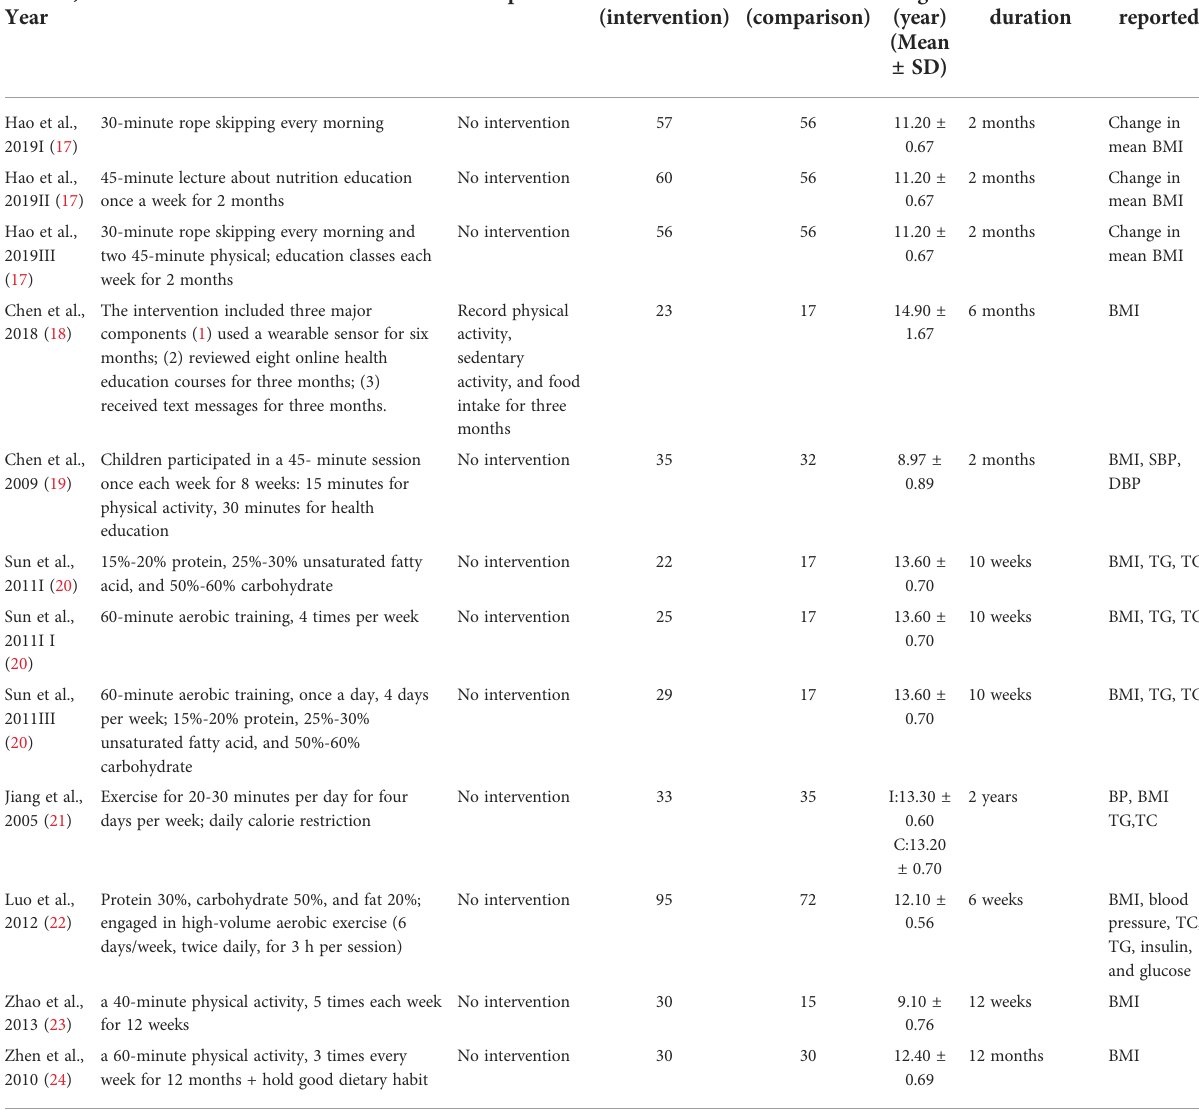
TABLE 1 Characteristics of studies on the effects of lifestyle interventions for children with overweight/obesity. Author,